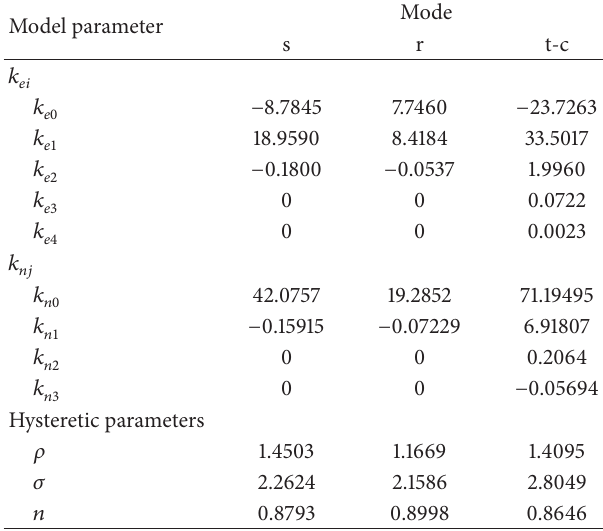
Table 2: Model parameter identification